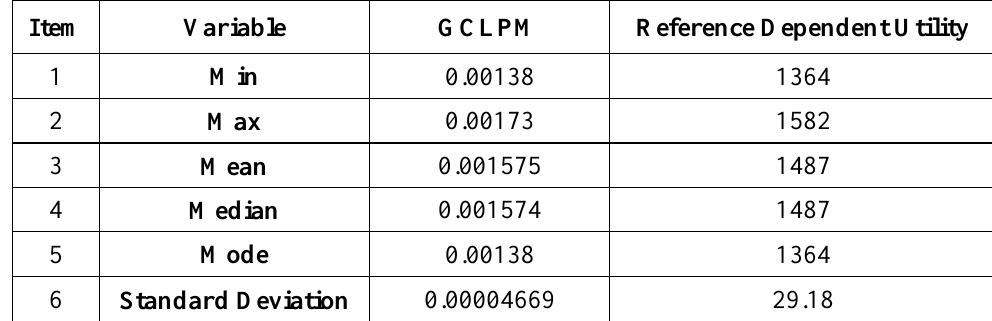
Table 5. Result Specification of Scenario 1 in Third